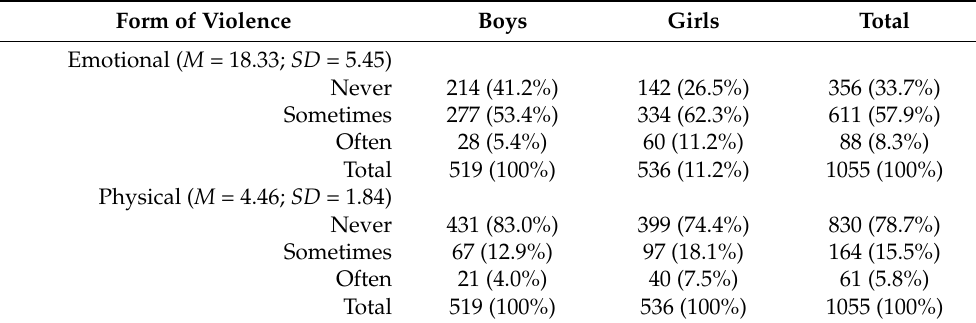
Table 1. Distribution of violence towards a partner by gender, as measured with CADRI. Form of Violence Boys Girls Total Emotional ( M = 18.33; SD = 5.45) Never 214 (41.2%) 142 (26.5%) 356 (33.7%) Sometimes 277 (53.4%) 334 (62.3%) 611 (57.9%) Often 28 (5.4%) 60 (11.2%) 88 (8.3%) Total 519 (100%) 536 (11.2%) 1055 (100%) Physical ( M = 4.46; SD = 1.84) Never 431 (83.0%) 399 (74.4%) 830 (78.7%) Sometimes 67 (12.9%) 97 (18.1%) 164 (15.5%) Often 21 (4.0%) 40 (7.5%) 61 (5.8%) Total 519 (100%) 536 (100%) 1055